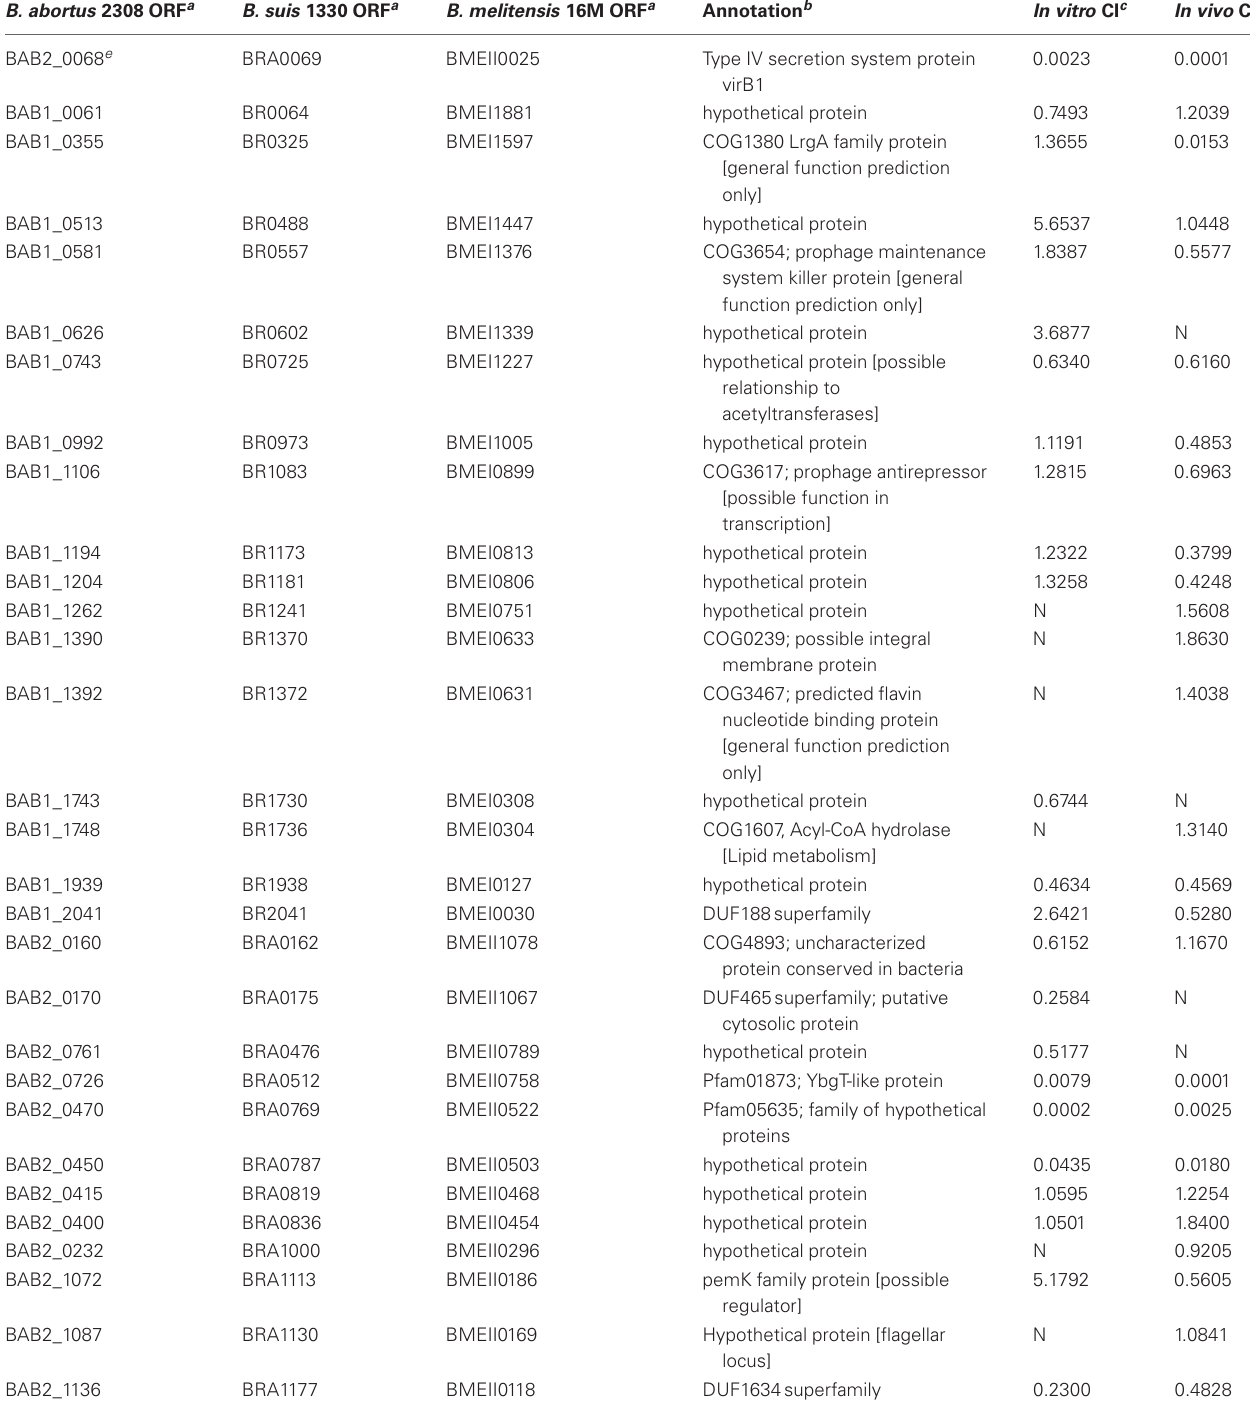
Table 2 | Small ORFs ( < 15kDa) with no assigned function, which are highly conserved in Brucella